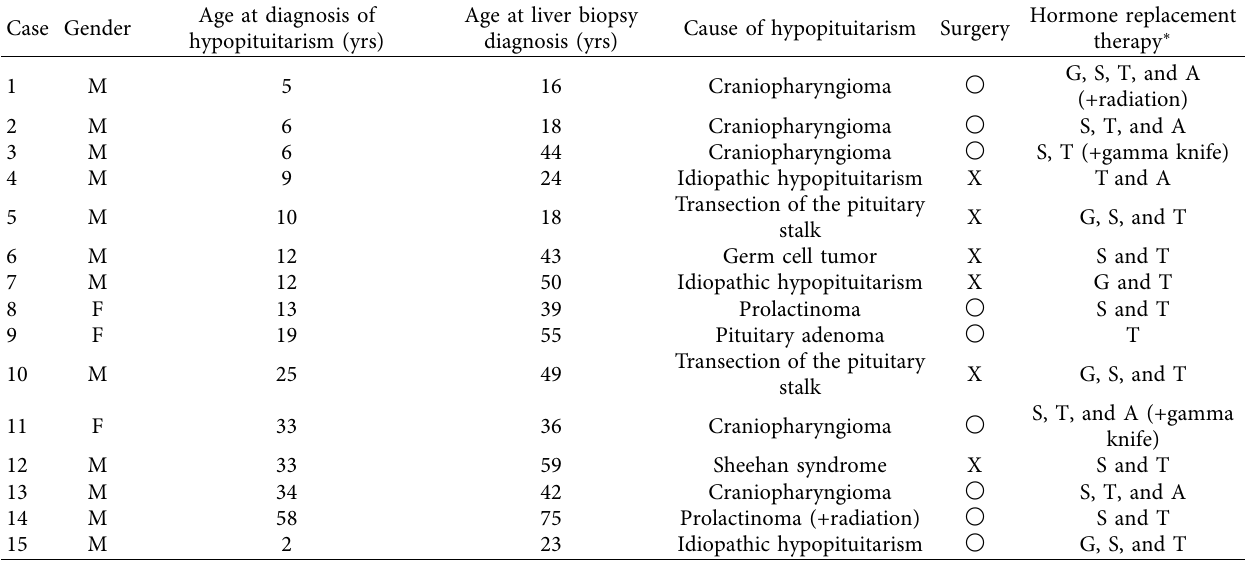
Table 1: Clinical features of NAFLD with hypopituitarism.